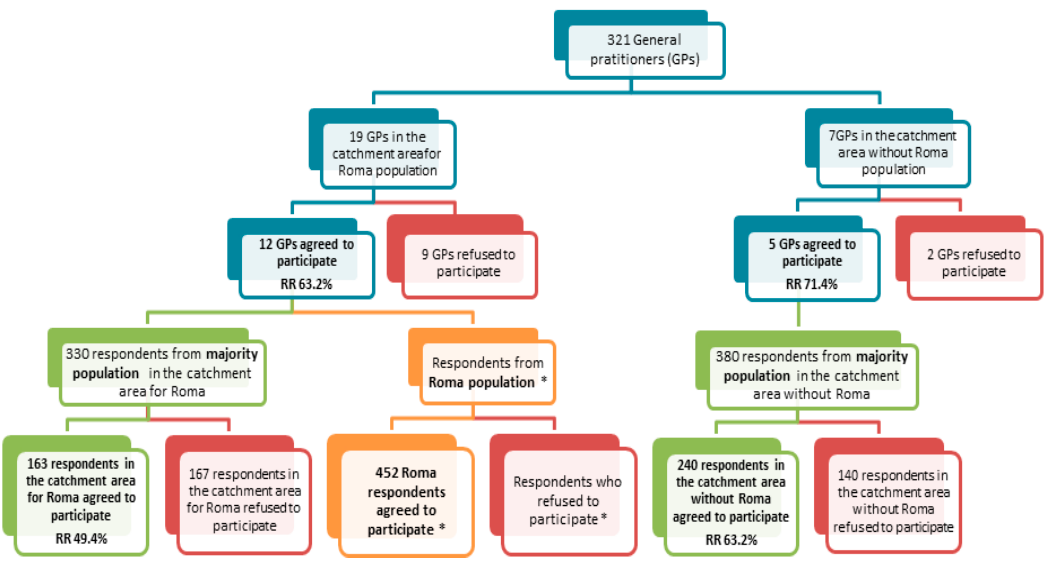
Figure 1. Recruitment of the Roma and non ‐ Roma population (GPs: general practitioners; RR: response rate; * missing data on response/non ‐ response in Roma).